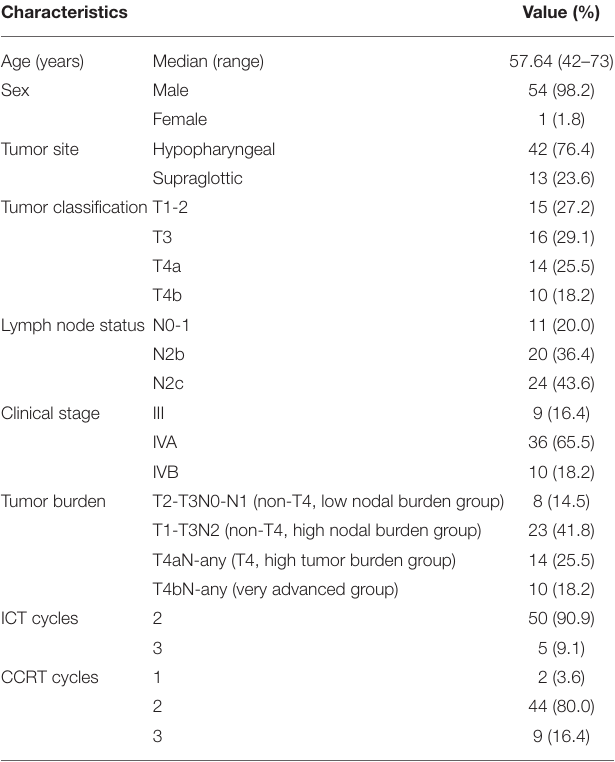
TABLE 1 | Patient characteristics ( n = 55).